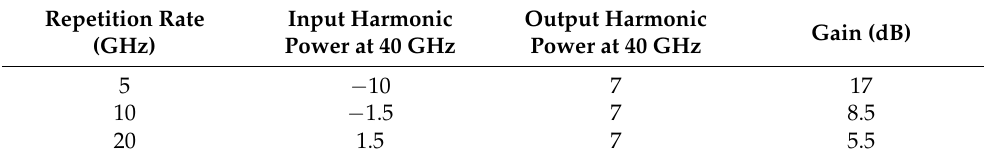
Table 4. The gain for the realistic “AND” signal practicability at the higher common harmonic frequency 40